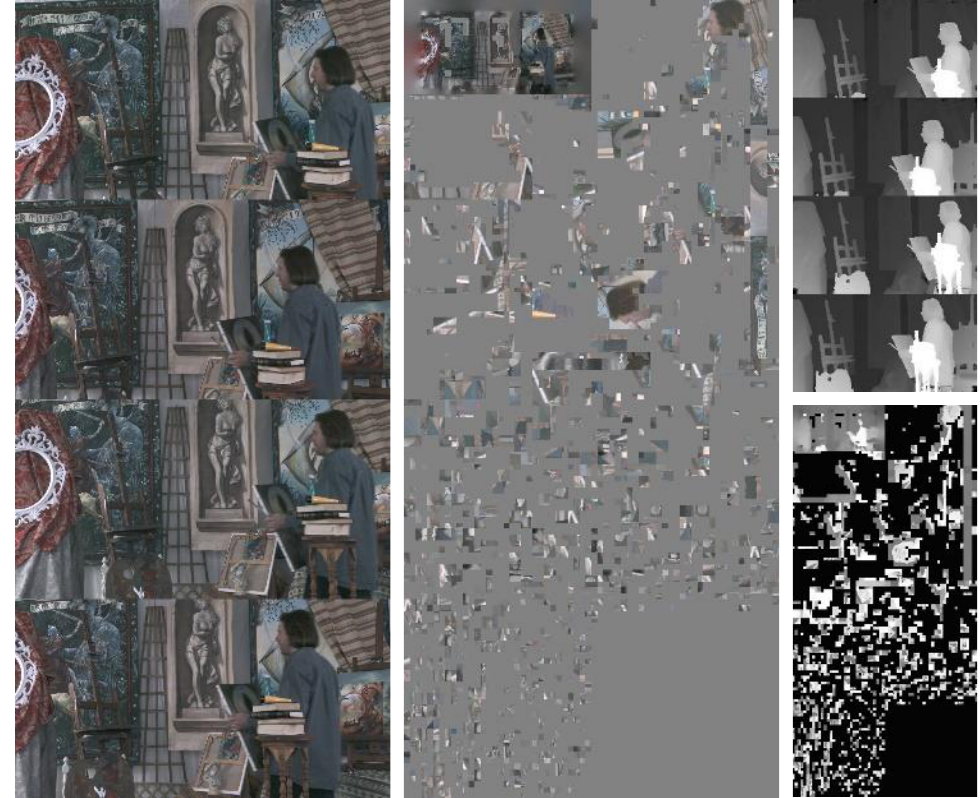
Figure 1. Four atlases for the Painter sequence [5]: two full-resolution texture atlases (left: first tex- ture atlas containing a subset of stacked input views, middle: second texture atlas containing “patches” from other input views), and two reduced -resolution depth atlases (right: two depth at- lases, containing depth values which correspond to the objects in both texture atlases).